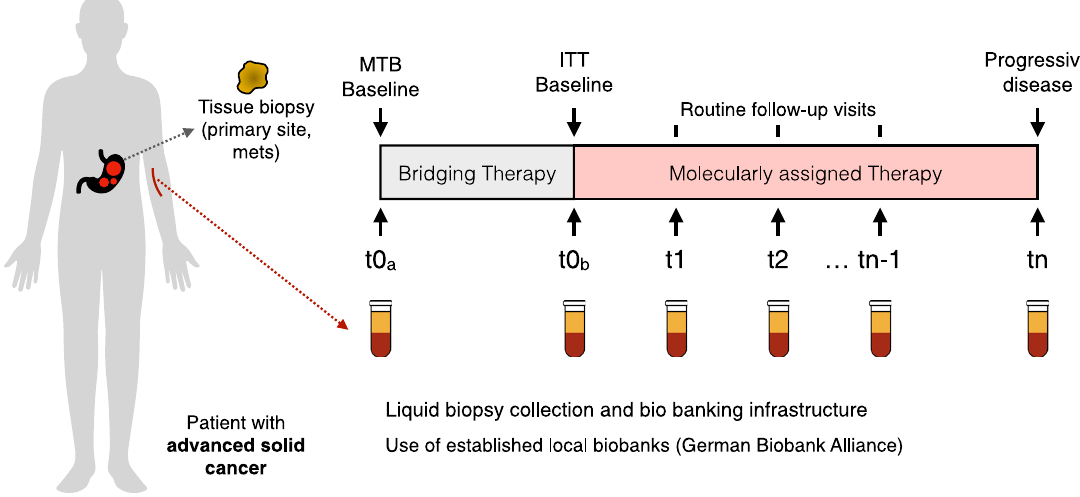
Figure 2: The EXLIQUID sampling